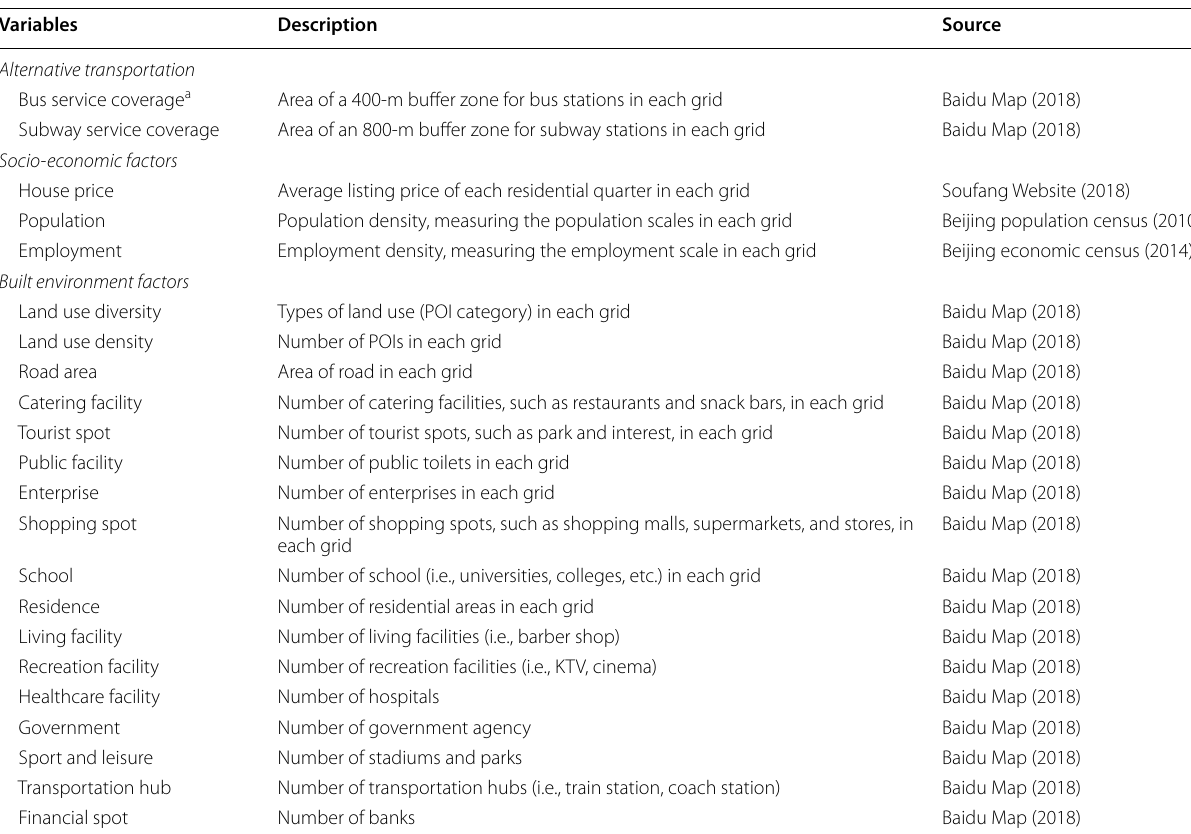
Table 1 Description of influence